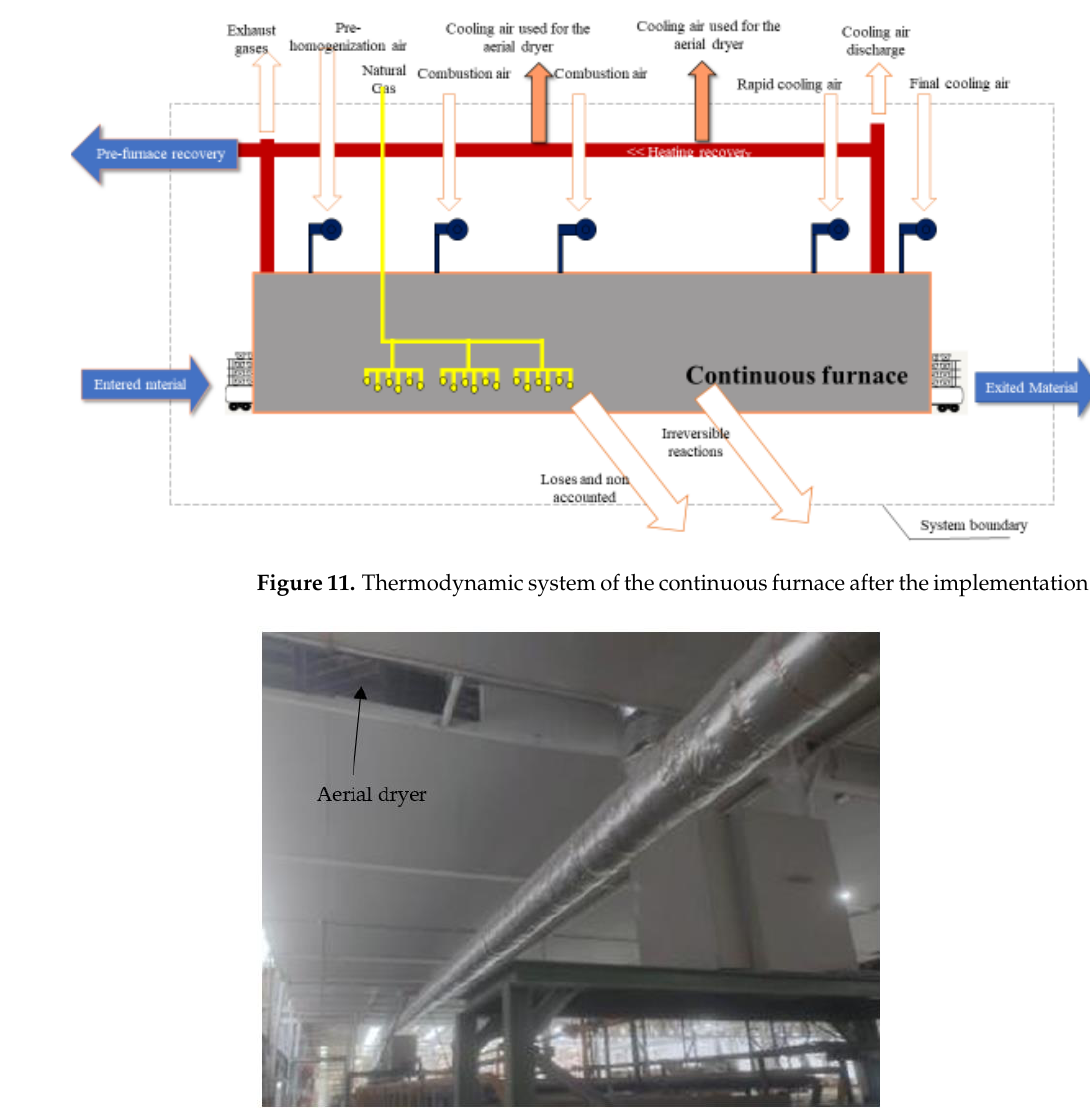
Figure 12. Conducts in link from the oven continuous to the air dryer. Table 14. Measurements were carried out in the holes of the continuous furnace ducts. Measurements Taken Outwards Hole Aerial Dryer